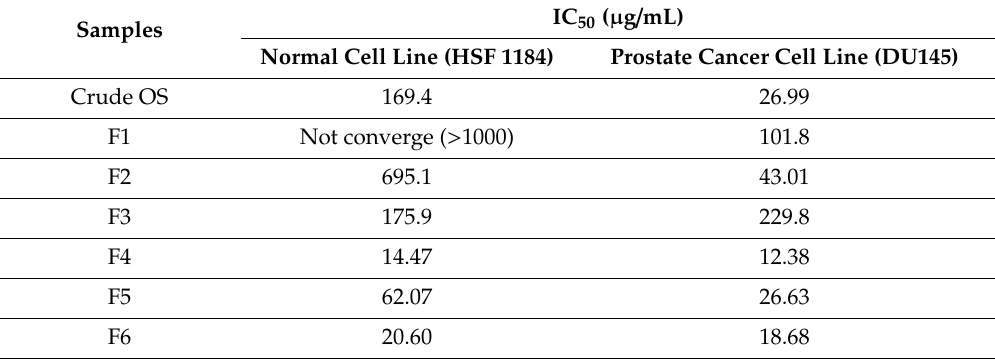
Table 7. IC 50 values of crude OS and its fractions on HSF 1184 and DU145. IC 50 represents the half maximal inhibitory concentration to determine the potency of the samples in inhibiting a biological